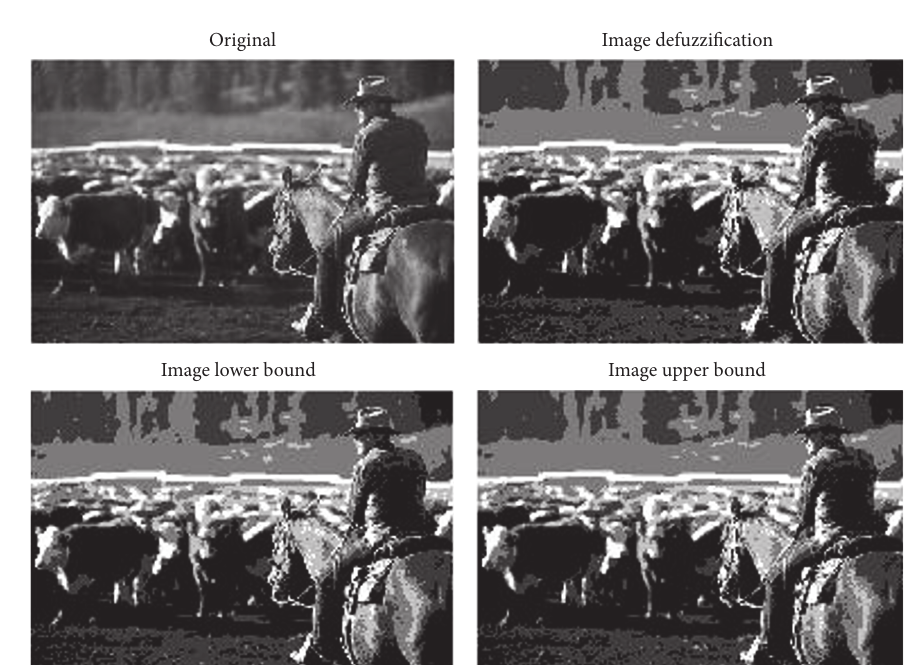
Figure 7: Resulting image clustering performed by the IT2FPCM algorithm for 5 clusters to Figure 2(e) because of the gray levels containing the